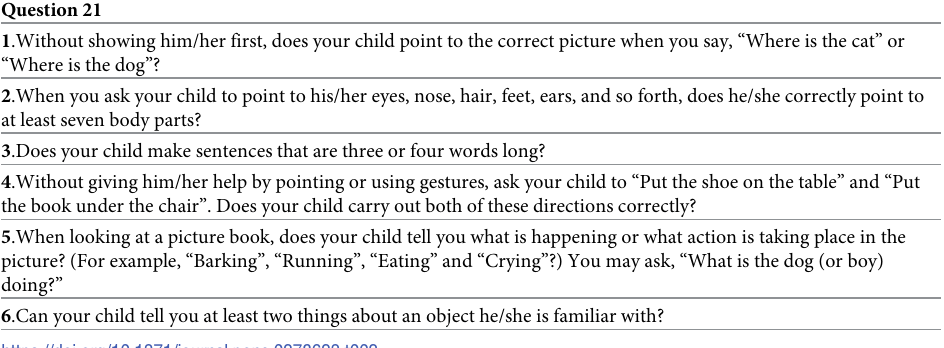
Table 2. In question 21, in the questionnaire at 3 years of age, mothers are asked to answer the six questions listed under in either “yes, often”, “sometimes”, or “not yet”, according to whether the child can do the activity (“yes” scored 10 points, “sometimes” = 5 points and “not yet” scored 0